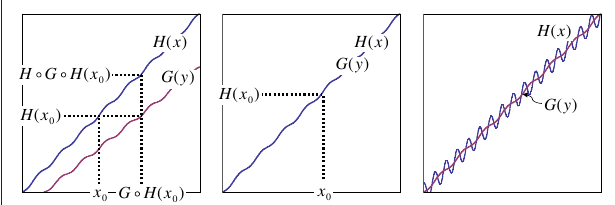
Figure 1 | x and y stimuli (for illustration purposes unidimensional) with the PSe functions H(x) and g(y). The abscissa segment and ordinate segment depict “sufficiently large” areas of stimuli around x and y = H ( x ), 0 0 0 respectively. Left-hand panel: the symmetry assumption, , is not MS satisfied, and the two functions do not cross within the areas depicted. Middle panel: is satisfied. Right-hand panel: is not satisfied but the MS MS two functions have numerous crossings within the areas depicted. In the left-hand panel the PSE for the PSE of x is not x itself, and analogously for 0 0 y = H ( x ): there are systematic differences between g H ( x ) and x , and 0 0 0 0 ◦ between H ( x ) and H g H ( x ) which may be detectable if the procedure is 0 0 ◦ ◦ repeated many times and the errors of matching are sufficiently well- behaved. In the middle panel the PSE for the PSE of x is x itself, and 0 0 analogously for y = H ( x ): if the procedure is repeated many times any 0 0 variance among successive adjustments of x and y will be due to matching errors